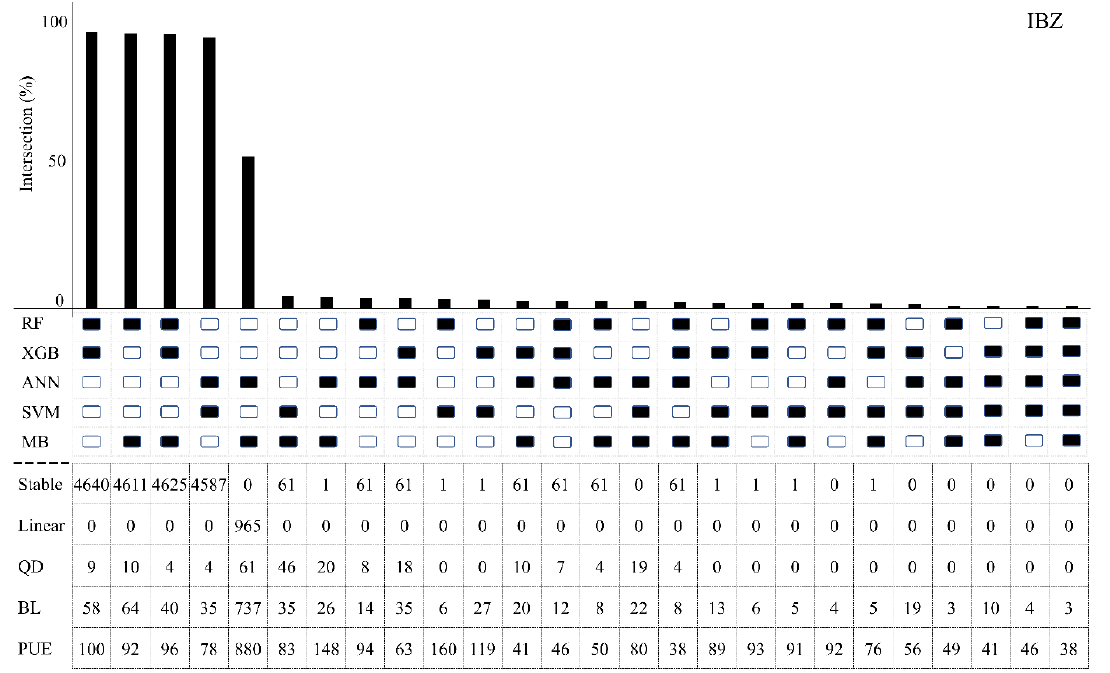
Figure 8. Pairwise intersections within 15,000 random samples of three datasets. The bar plots indicate the percentage of intersection among the models assigned by filled boxes. The tables also consist of similar TSs, predicted by five models in each data collection separately. Note that QD and BL stand for Quadratic and Bilinear trends, respectively.